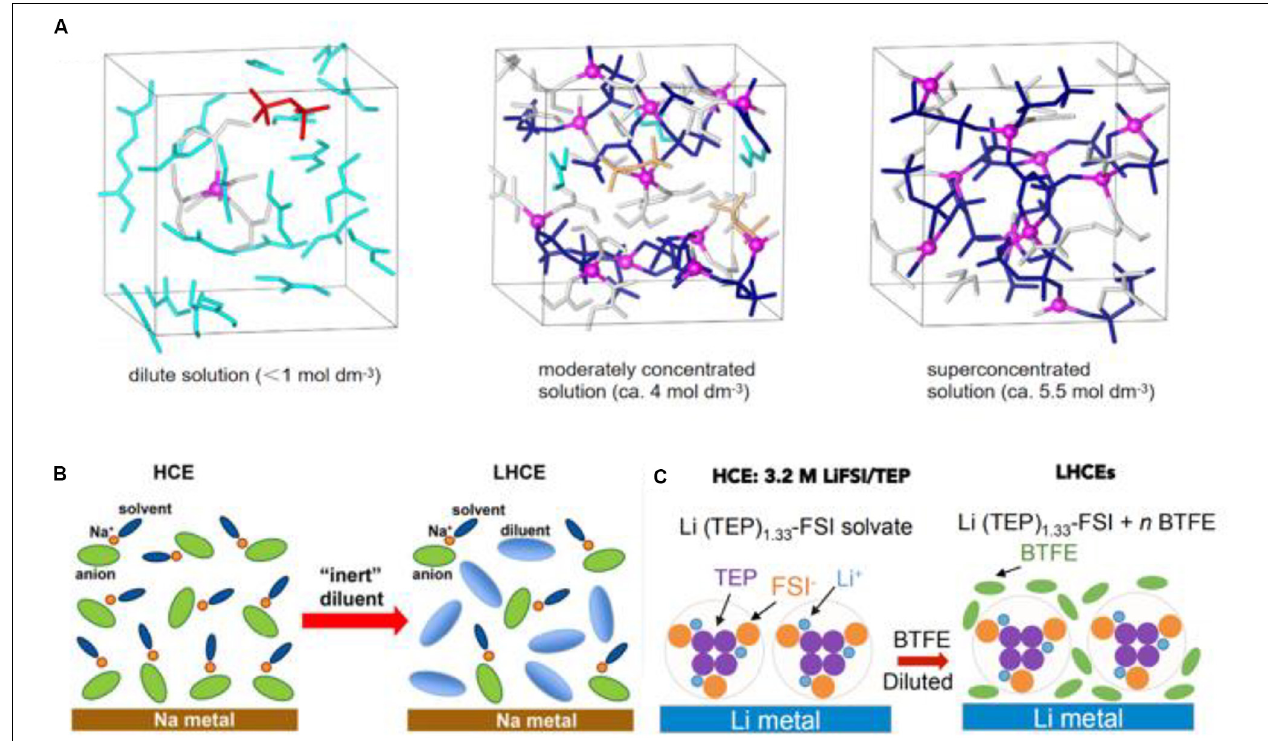
FIGURE 5 | The solvated coordinate structure of an electrolyte dependent on salt concentration. (A) The solution structure models under equilibrium trajectories of different solution concentrations by DFT-MD simulations. Reproduced with permission from Ref. Wang et al. (2016). Copyright 2016, Springer Nature. (B) The solvated coordinate structure in high concentrated electrolytes, and the participation of diluent constructing the special coordinate structure. Reproduced with permission from Ref. Zheng et al. (2018). Copyright 2018 American Chemical Society. (C) The addition of dilution by BTFE changes the solution structure to form LHCE. Reproduced with permission from Ref. Chen et al. (2018b). Copyright 2018